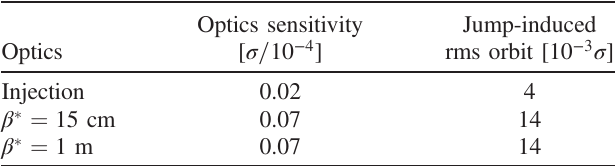
TABLE V. R.m.s. closed orbit variation at HL – LHC